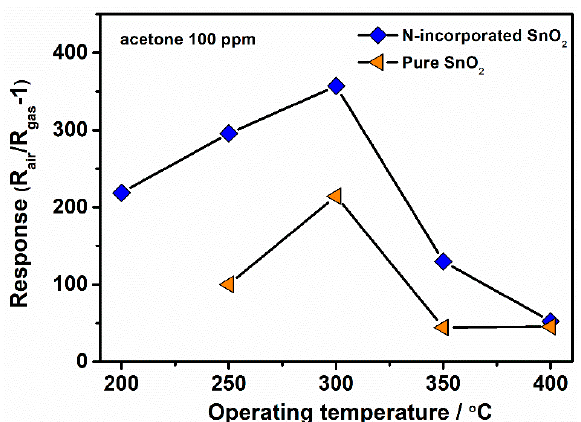
Figure 11. Temperature dependent responses comparison of N-incorporated SnO 2 and pure SnO 2 gas sensors.